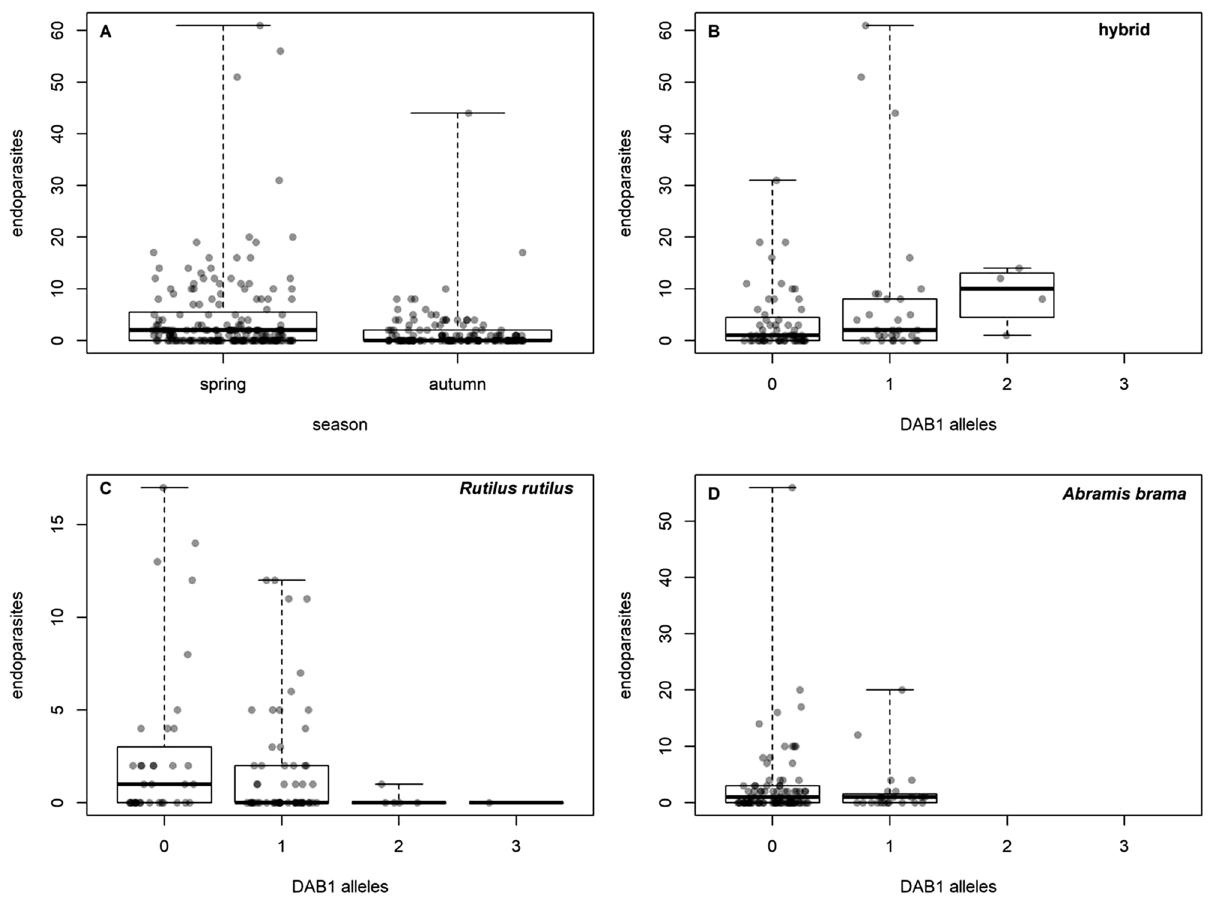
Figure 6. Effect of season on endoparasite abundance ( A ) and effect of the number of DAB1 alleles on endoparasite abudance in hybrids ( B ), R. rutilus ( C ) and A. brama ( D